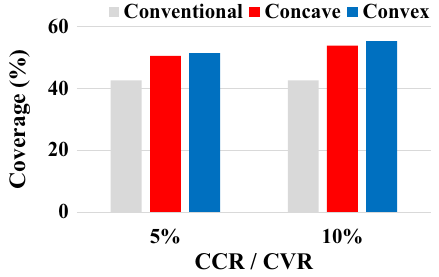
Figure 17. Coverage according to model type measured by